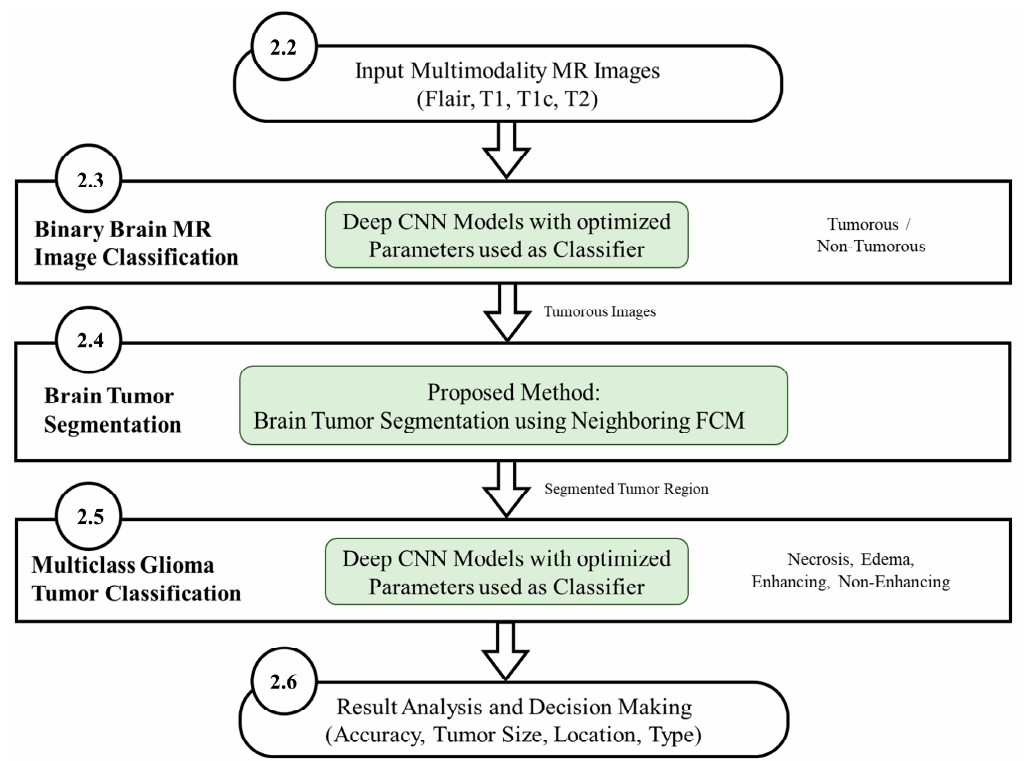
Figure 5. Workflow diagram of the proposed methodology (Green highlighted sections represent contributions in this